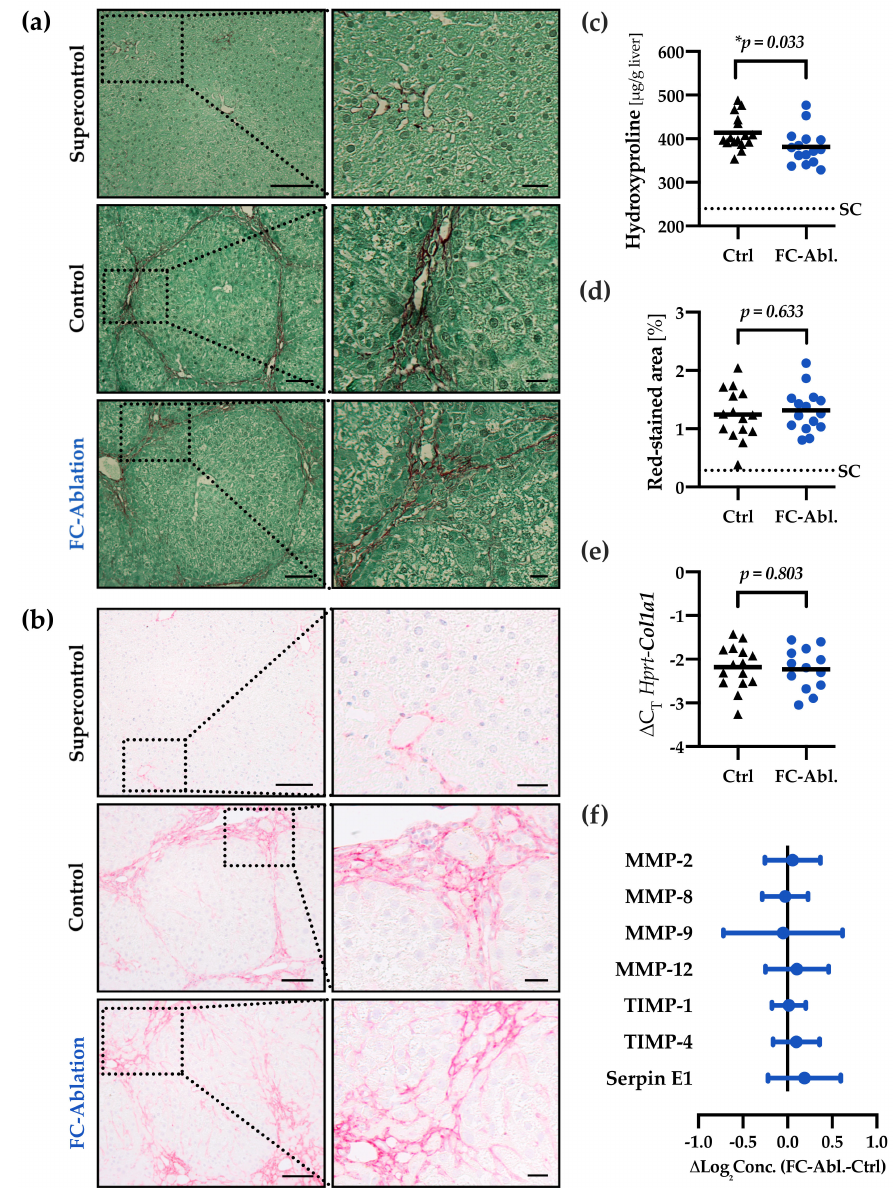
Figure 2. Fibrocyte ablation attenuated hepatic fibrogenesis. Fibrillar collagen distribution was visualized by ( a ) Sirius Red / Fast Green staining and ( b ) immunohistochemical staining of collagen I on formalin fixed, para ffi n-embedded liver sections. TAA-treatment caused pronounced periportal and bridging fibrosis as well as faint chicken wire sinusoidal fibrosis in the control- and fibrocyte-ablated group. Dotted boxes are shown in enlarged panels on the right side. Magnification 200 × , bars 100 and 25 µ m. ( c ) Quantitative assessment of hepatic hydroxyproline content revealed a reduction of fibrillar collagens in mice lacking fibrocytes. The assay was performed three times. Mean values of each individual mouse are depicted by black triangles (control) or blue dots (fibrocyte ablation). The solid line depicts the group mean, the dotted line the mean hydroxyproline level in untreated supercontrols (SC). ( d ) Morphometric analysis of Sirius Red / Fast Green-stained sections displayed a comparable extent of red-stained areas in TAA-treated mice with and without fibrocyte ablation. A total of 1361 images were analyzed (2–134 per mouse). ( e ) The transcriptional levels of Col1a1 were equal throughout both groups. ( f ) Relative protein levels of MMP-2, MMP-8, MMP-9, MMP-12, TIMP-1, TIMP-4, and Serpin E1 were assessed utilizing a multiplex ELISA and remained constant as a result of fibrocyte ablation. Absolute concentrations and individual p -values are provided in Figure